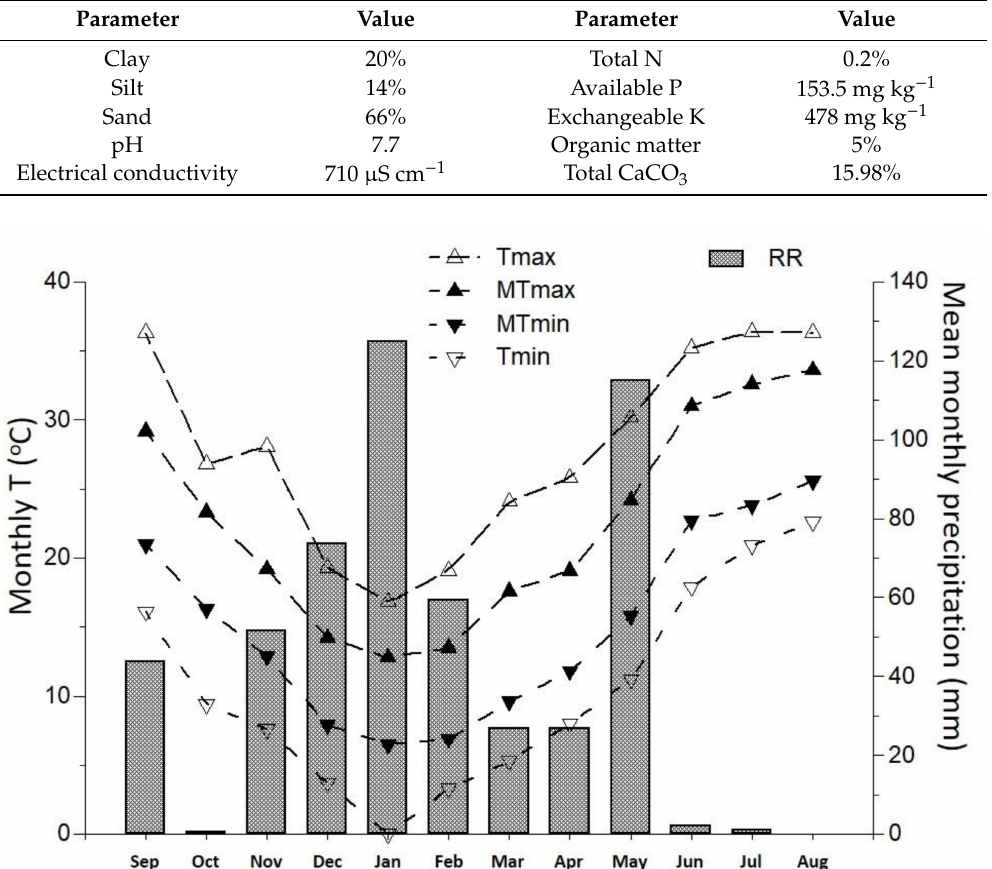
Figure 2. Monthly maximum (Tmax), average maximum (MTmax), average minimum (MTmin), and minimum (Tmin) and precipitation (RR) during the 2nd experimental year (September 2018–August 2019) in Athens,